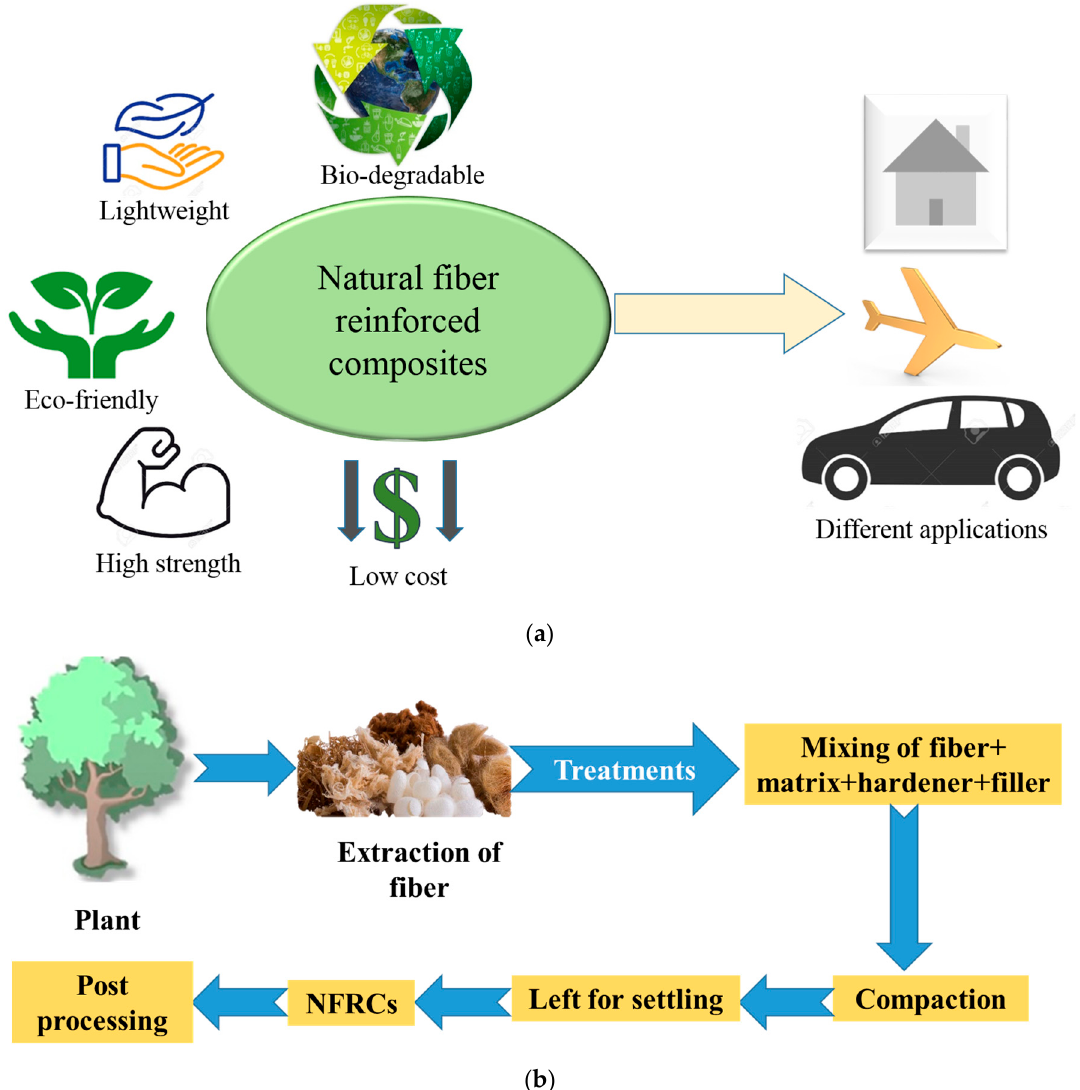
Figure 1. ( a ) NFRCs characteristics in construction and automotive applications. ( b ) Steps involved in NFRCs fabrication. in NFRCs